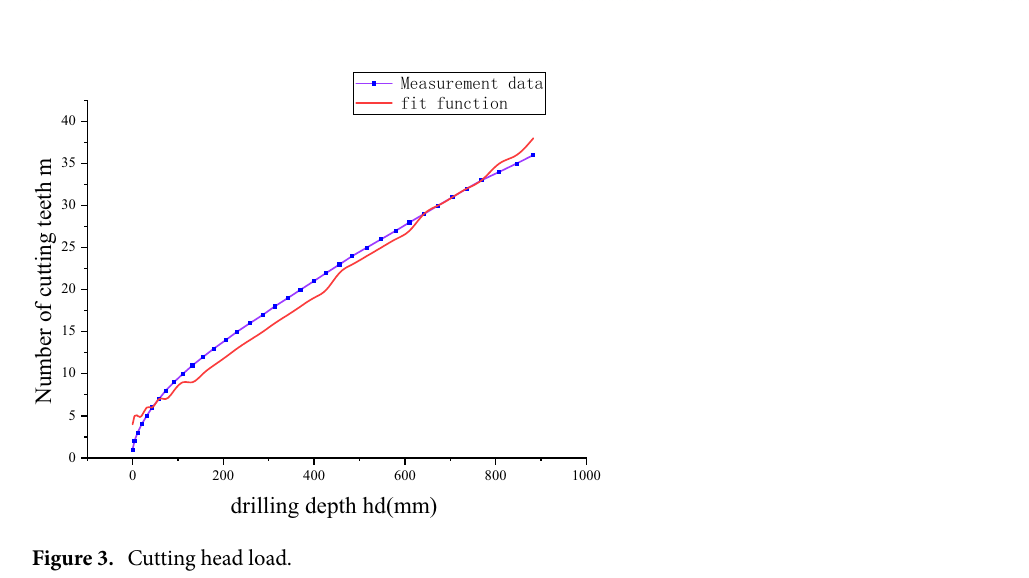
Figure 3. Cutting head